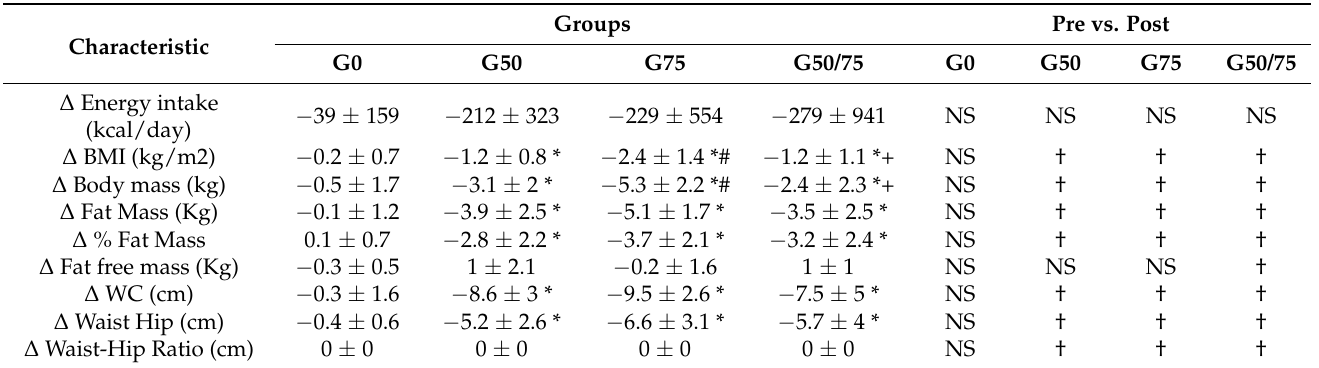
Table 2. Change in energy intake. anthropometric and body composition measurements following the 12-week intervention.